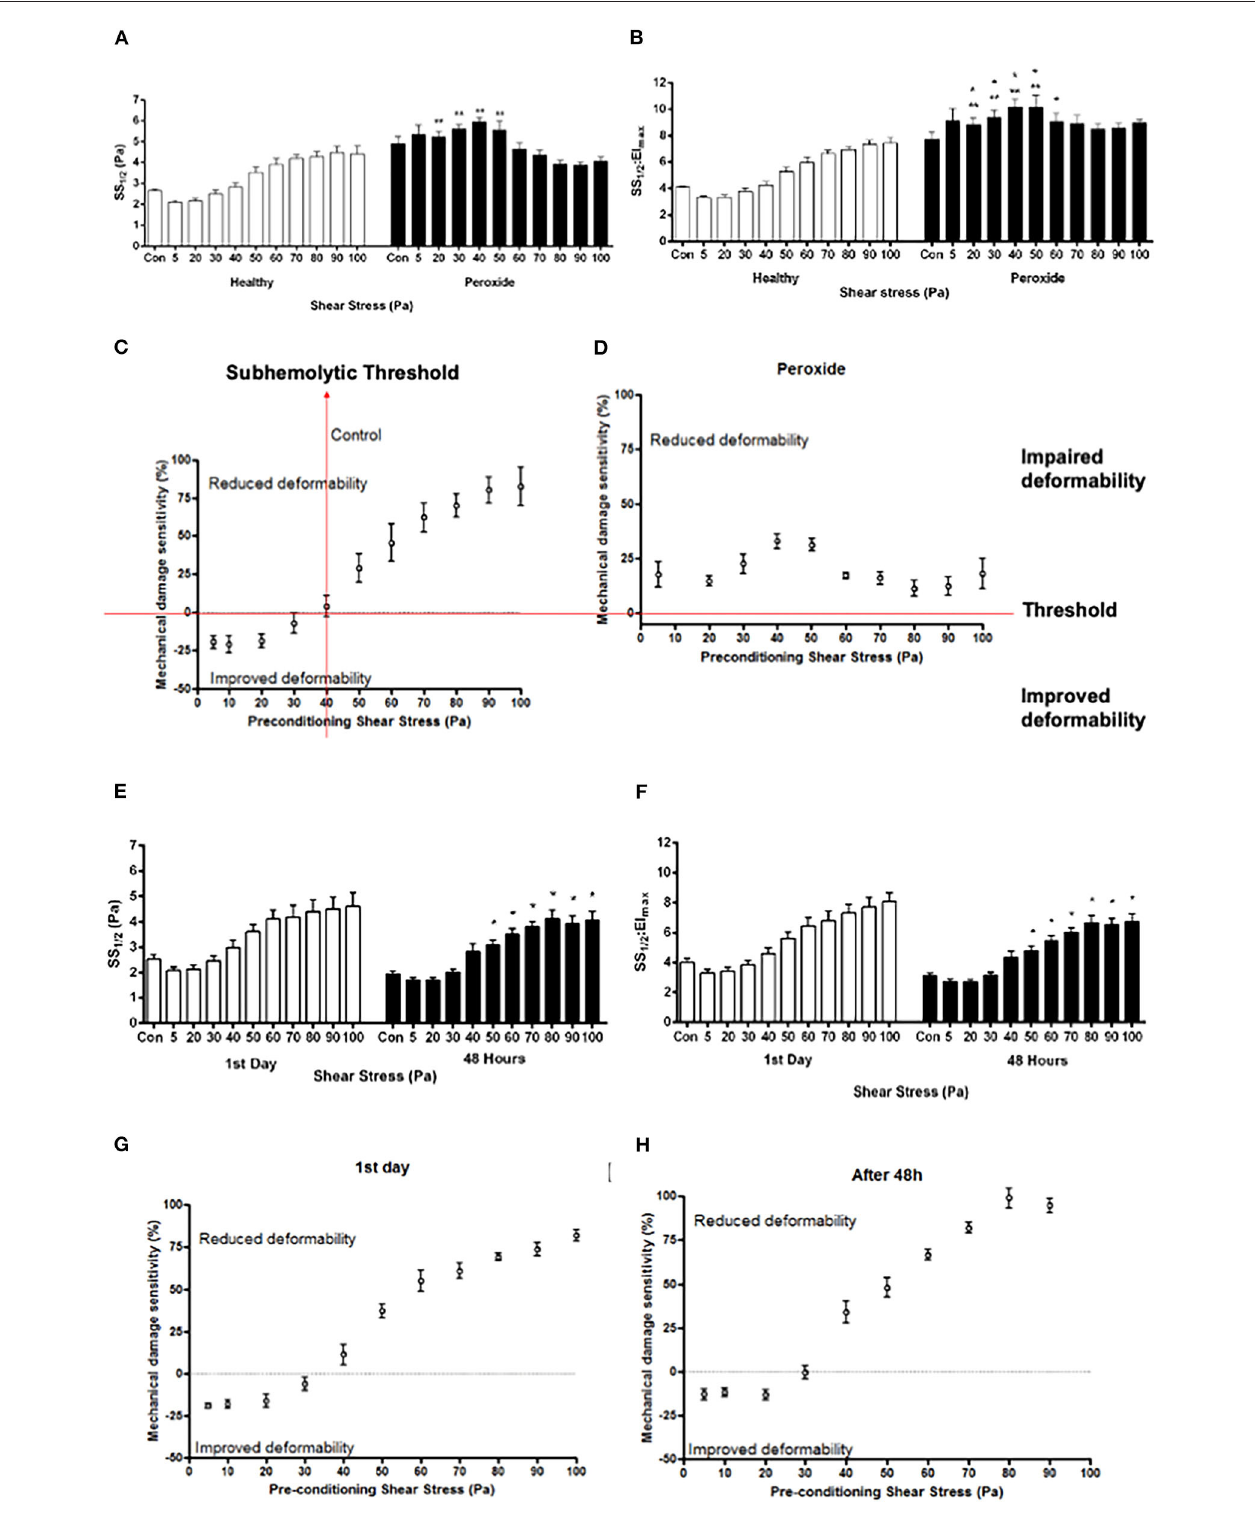
FIGURE 2 | Curve-fit parameters that describe the elongation index (EI)–SS relationship for RBCs (A, B, E, F) and mechanical damage sensitivity to SS (C, D, G, H) exposed to 5–100Pa for 300s. Parameters shown in (A,E) are the SSs required for half-maximal deformation (SS 1 / 2 ) and in (B,F) the ratio of SS 1 / 2 divided by EI max . Panels A, B, C, and D represent oxidative stress (hydrogen peroxide), and panels E, F, G, and H represent metabolic depletion (48h) groups. Con: RBC sample before preconditioning SS. Data are mean ± SEM. of n = 5. ** p < 0.05 refers to the difference from healthy group, and * p < 0.05 refers to the difference from Con (one-way